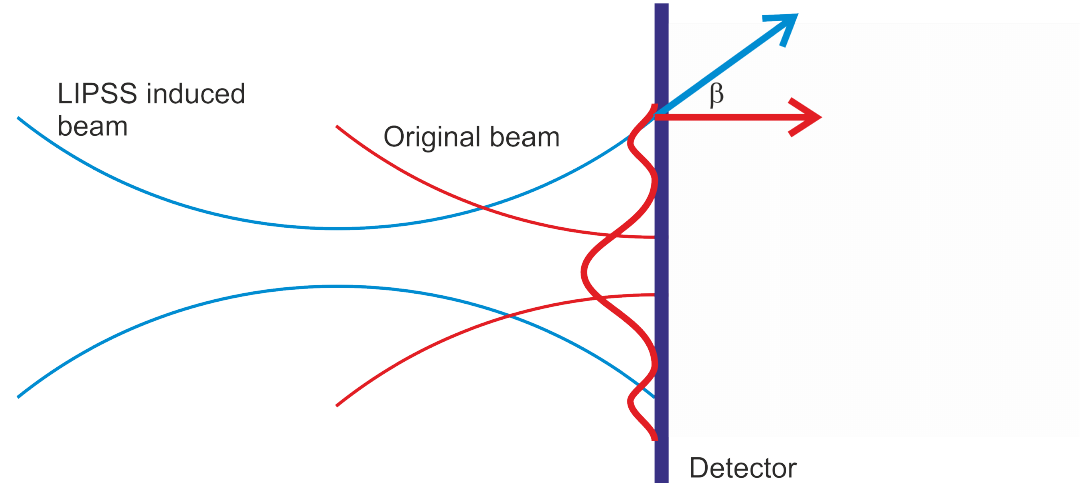
Figure 8. New LIPSS-induced angular components to the backscattered light are focused in front of the original image plane. Interference between the original and LIPSS-induced beam in the detector plane gives rise to the experimentally observed fringe